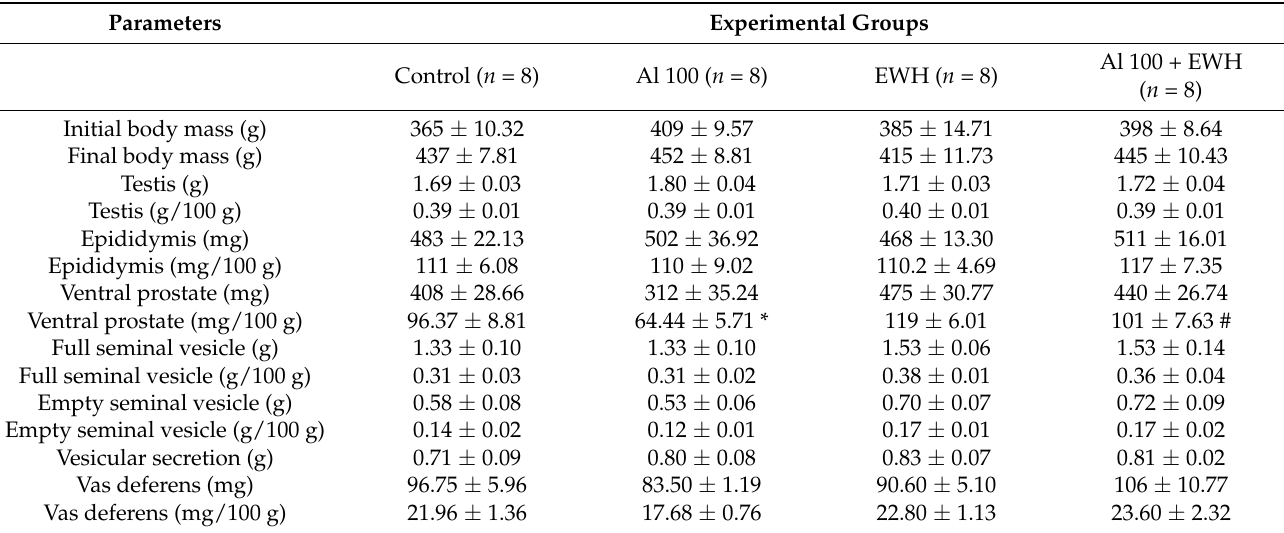
Table 2. Effect of EWH on body mass (g), absolute (g or mg) and relative (g/100 g or mg/100 g) mass of reproductive organs of male rats exposed to AlCl 3 at 100 mg/kg for 42